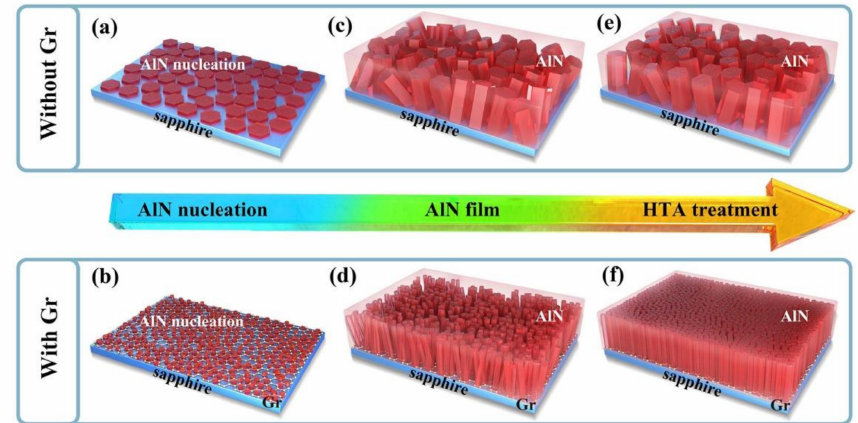
Figure 22. Mosaic models of AlN grown on bare sapphire substrate and graphene-buffered sapphire substrate: ( a , b ) AlN nucleation stage; ( c , d ) AlN growth stage; ( e , f ) after HTA. Due to the increased nucleation sites caused by N 2 plasma pretreatment, AlN grown on graphene-buffered sapphire demonstrates higher nucleation density with smaller size. During the recrystallization process of HTA, those small-diameter AlN columns on graphene-buffered sapphire are easily rearranged, reducing the tilt and twist between different AlN columns. Reprinted from [98], with the permission of AIP Publishing.